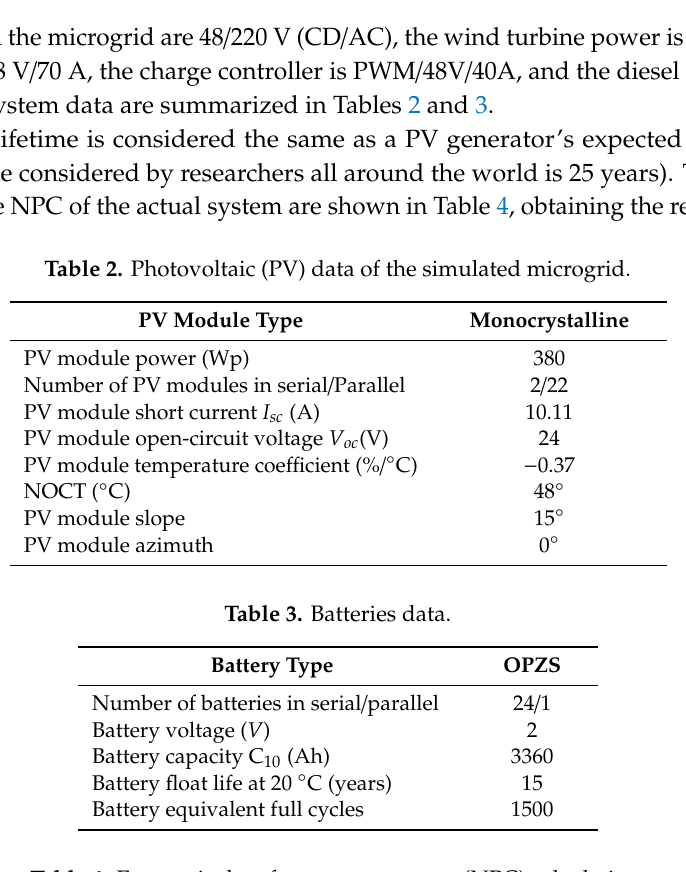
7 of 17 Figure 2. Wind speed (in an average year) at the microgrid location .